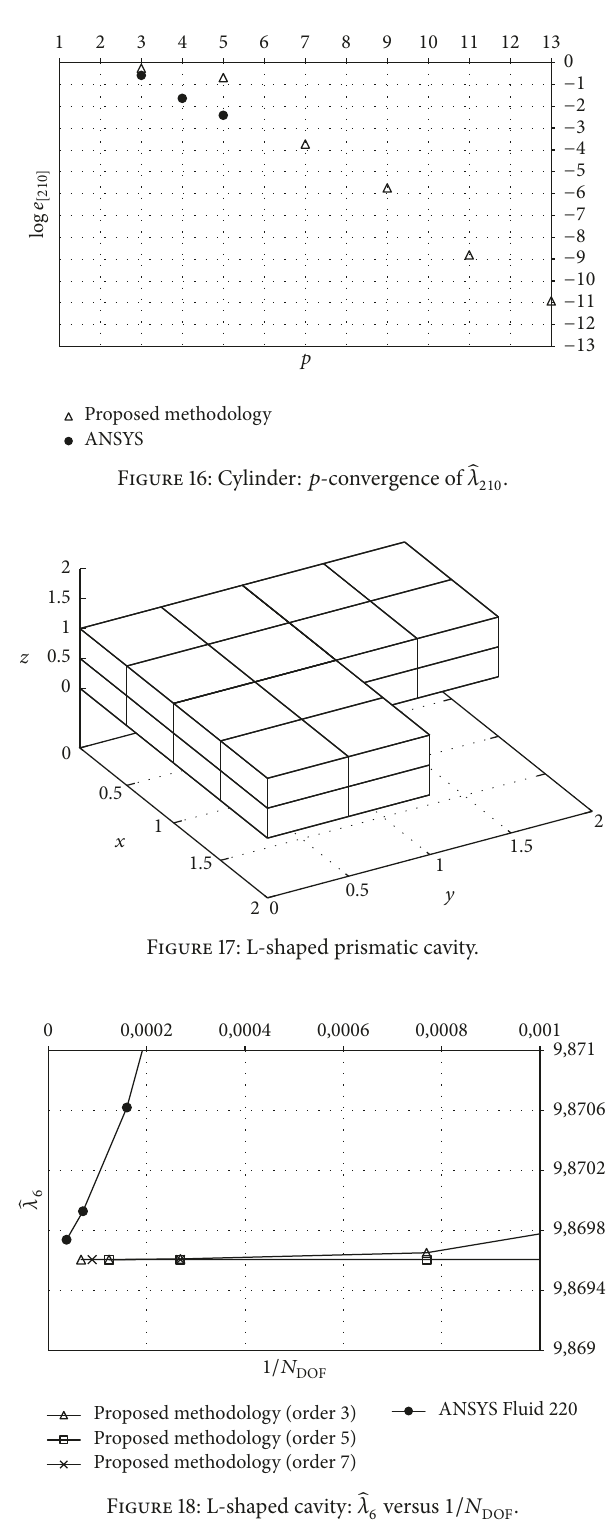
Figure 15: Cylinder: 𝑝 -convergence of